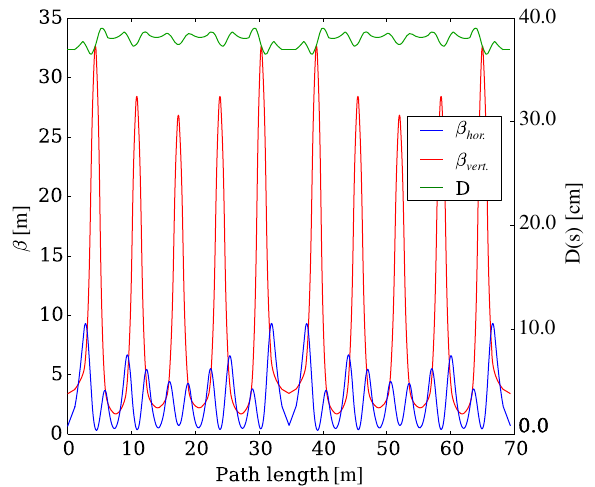
FIG. 16. The horizontal and vertical β -functions and dispersion at the injection energy of 30 MeV are shown. The long straight racetrack section occurs just after 30 m.